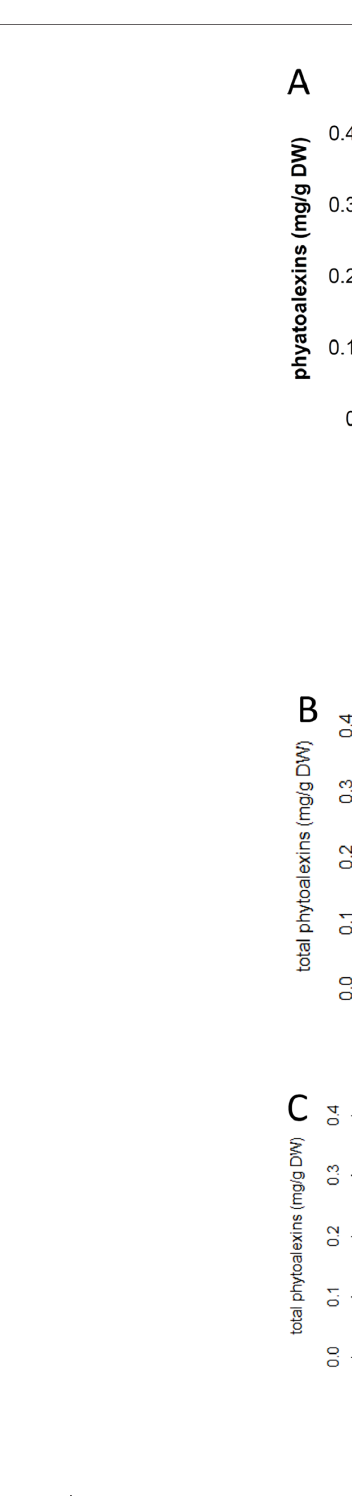
FIGURE 6 | Analysis of phytoalexins in roots of the three genotypes M26, B63, and MAL0595, which were grown for 4 weeks on ARD and g ARD soils from the two sites Heidgraben and Meckenheim. (A) Levels of individual phytoalexins identi fi ed by gas chromatography – mass spectrometry (GC-MS). Compound retention index (RI) 2,070, isomer of noraucuparin; 2,090, aucuparin; 2,121, noraucuparin; 2,131, 2-hydroxy-4-methoxydibenzofuran; 2,179, isomer of eribofuran; 2,193, 2'- hydroxyaucuparin; 2,228, eribofuran; 2,259, noreriobofuran; 2,284, isomer of hydroxyeribofuran; 2,289, isomer of noreriobofuran; 2,399, methoxyeribofuran; 2,479, 3,9-dimethoxy-2,4-dihydroxydibenzofuran. (B, C) Total phytoalexin content as a function of genotype and soil, respectively. Different letters indicate signi fi cant differences revealed by Tukey test (n = 8 for B and n = 6 for C) applied to the total